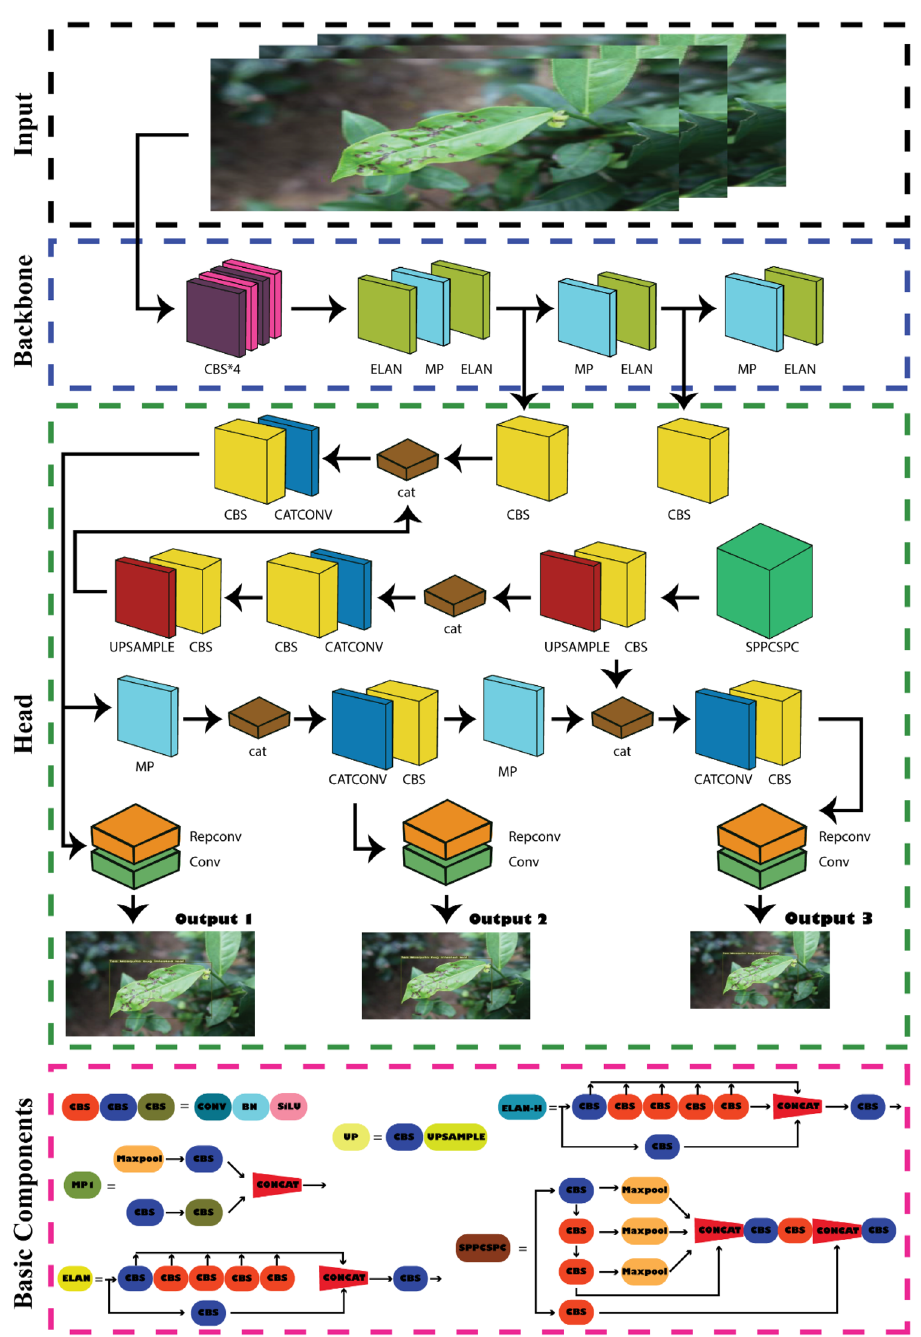
Figure 5. Network architecture diagram of YOLOv7. The whole architecture contains 4 general modules, namely, an input terminal, backbone, head, and prediction, along with 5 basic components: CBS, MP, ELAN,